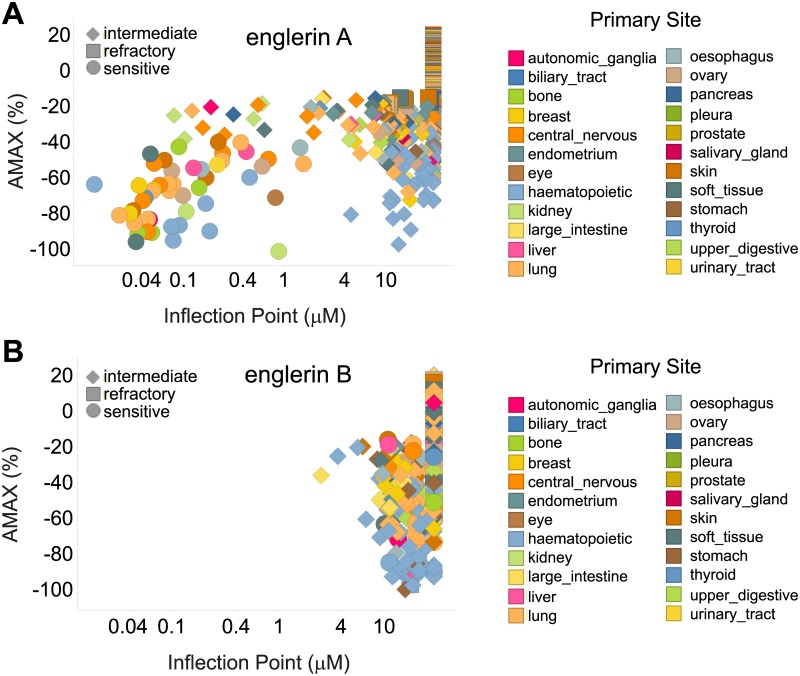
Englerin A affects proliferation of a subset of cancer cell lines across many cell lineages while englerin B is inactive.(A) Scatterplot of englerin A cell line profiling experiment. (B) Scatterplot of englerin B cell line profiling experiment. Each point represents effect of englerin A or B on growth of a single tumor cell line. Y-axis indicates maximal effect on growth and X-axis indicates potency. Tumor cell line lineage is indicated by color and the legend is in the figure. Englerin A sensitive (circles), englerin A refractory (squares) and englerin A intermediate (diamonds) cell line calls are indicated.